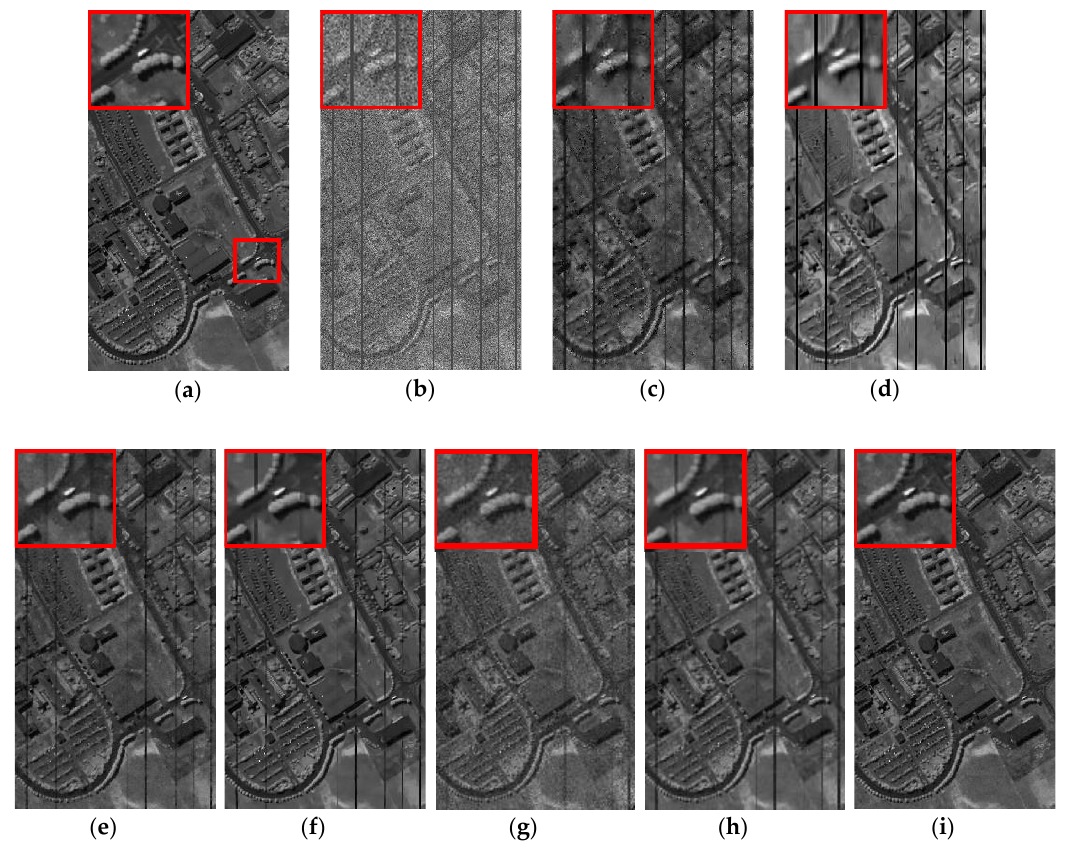
Figure 10. Restored results of band 90 corrupted with a mixture of Gaussian noise, Poisson noise and dead pixel lines:( a ) clean HSI; ( b ) noisy HSI; ( c ) KSVD; ( d ) BM3D; ( e ) ANLM3D; ( f ) BM4D; ( g ) LRMR; ( h ) DDL3+FT; ( i ) Our method.